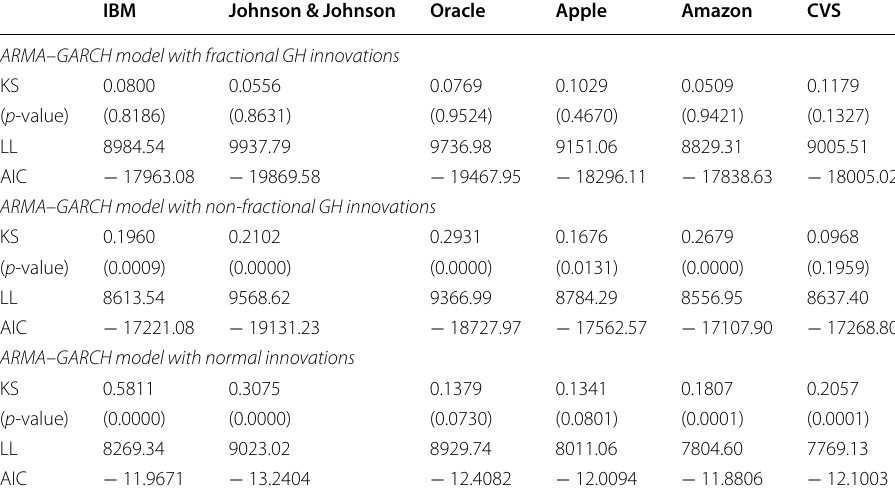
Table 6 Small sample: goodness-of-fit test for ARMA–GARCH models